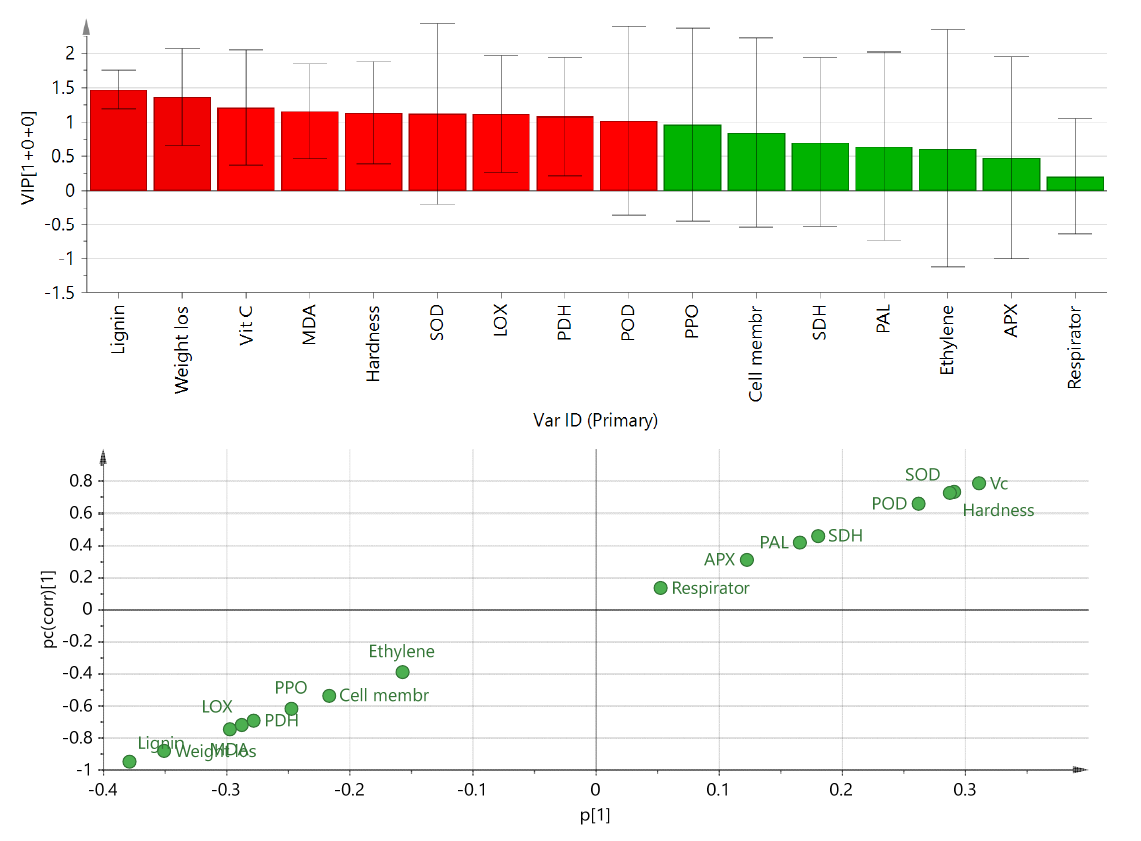
Figure 8. VIP and S-plot plots of storage quality and enzyme activity of root mustard treated with control and 1.0 µL L − 1 1-MCP during ambient temperature storage. Red represents VIP values greater than 1, and green represents VIP values greater than 1.